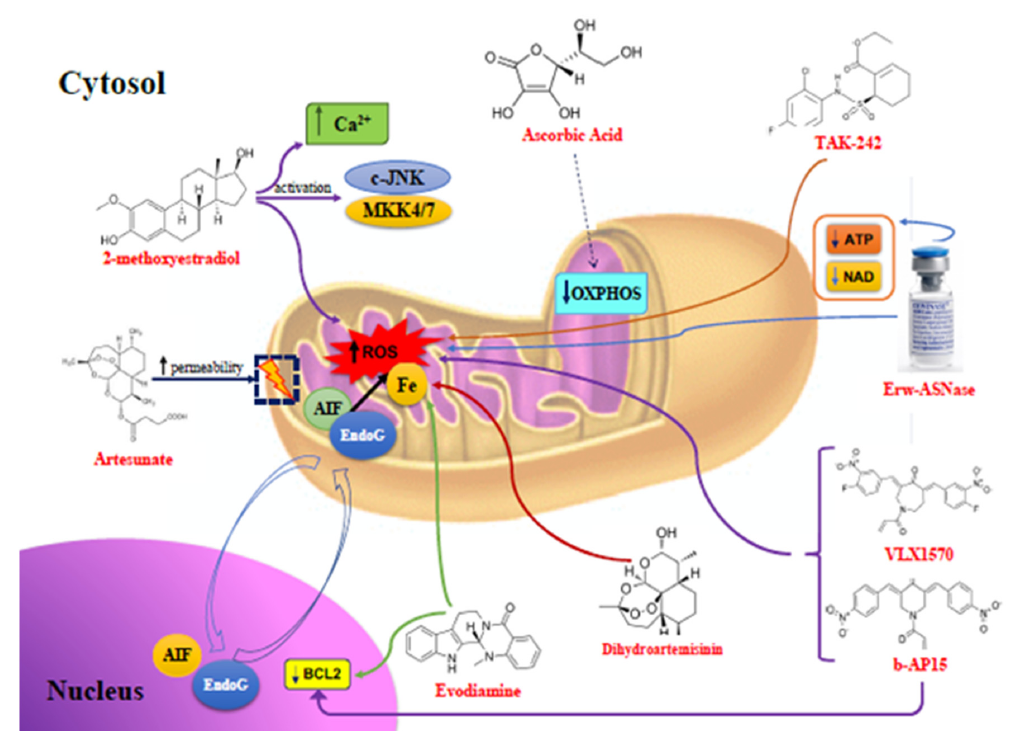
Figure 1. Caspase-independent mechanism of action of anti-mitochondrial agents. Mitochondrial targets of compounds with pro-apoptotic actions on myeloma cells are shown: 2-methoxyestradiol increases mitochondrial ROS production and increases Ca2+ levels in the MM cells, also causing JNK and MKK4/7 activation; artesunate increases the mitochondrial membrane permeability and ROS concentration in MM cells, inducing mitochondrial protein transfer into the nucleus, which causes DNA damage, AIF, and EndoG activation; ascorbic acid reduces cell respiration by the direct inhibition of mitochondrial oxidative phosphorylation in MM cells; DHA induces a mitochondrial Fe2+-dependent ROS increase, also inhibiting BCL2 when associated with Dexa; Evo activates mitochondrial pathways and inhibits nuclear BCL2 with an ROS increase; b-AP15 overcomes BTZ-resistance, inducing oxidative stress via ROS, through the induction of chaperones HSP70B’ and HSP40, then resulting in Nrf-2 and its target HO-1 induction; VLX1570 determines cell oxidative stress, inducing the accumulation of polyubiquitin chains, causing MM cell death in combination with Dexa in vivo; Erw-ASNase in combination with CFZ causes MM cell death, increasing ROS generation and Nrf2 deregulation, and reducing the ATP and NAD intracellular content; TAK-242 associated with BTZ generates an ROS and RNS increase, causing MM cell death. Abbreviations : ROS, Reactive Oxygen Species; JNK, c-Jun N-terminal Kinase; MKK4/7, Mitogen-activated protein Kinase Kinase 4/7; MM, multiple myeloma; AIF, Apoptosis Inducing Factor; EndoG, Endonuclease G; OXPHOS, Oxidative Phosphorylation; DHA, Dihydroartemisinin; BCL2, B-Cell Lymphoma 2; Dexa, Dexamethasone; Evo, Evodiamine; b-AP15, deubiquitinase inhibitor b-AP15; BTZ, Bortezomib; HSP70B’, Heat Shock Protein 70B’; HSP40, Heat Shock Protein 40; Nrf-2, Nuclear factor erythroid 2-Related Factor 2; HO-1, Heme Oxygenase 1; VLX570, deubiquitinase inhibitor VLX570; Erw-ASNase, L-Asparaginase purified from Erwinia chrysanthemi ; CFZ, carfilzomib; ATP, Adenosine TriPhosphate; NAD, Nicotinamide adenine dinucleotide; TAK-242, Toll-like receptor 4 Antagonist 242 or Resatorvid; and RNS, reactive nitrogen